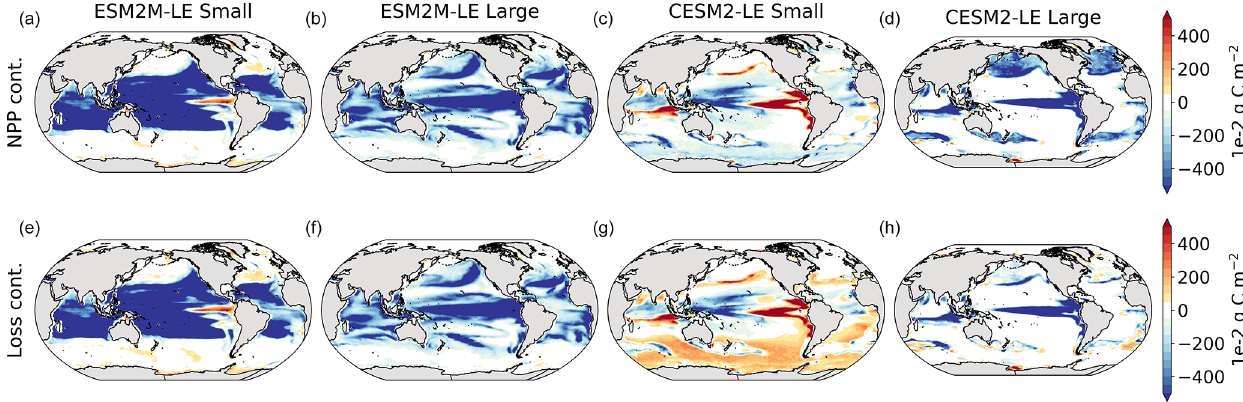
Figure B9. Contributions (1 × 10 − 2 gCm − 2 d − 1 ) of small- and large-phytoplankton NPP and Loss to the buildup of the maximum biomass